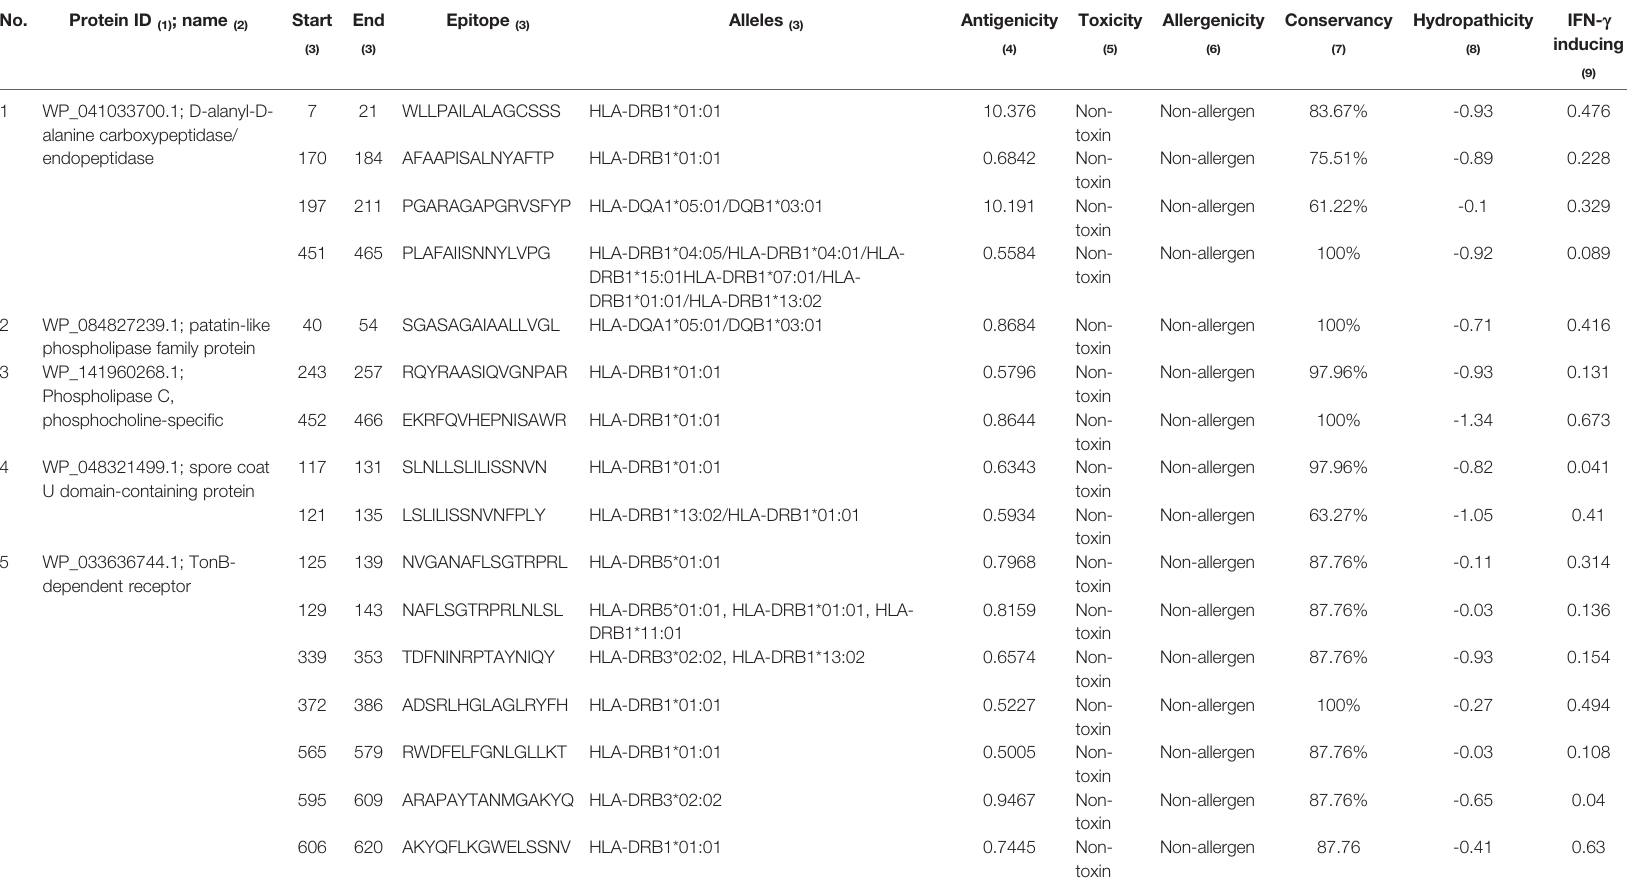
TABLE 3 | Identi fi cation of MHC-II epitopes and antigenicity, toxicity, conservancy, hydropathicity and IFN- g inducing pro fi le prediction.